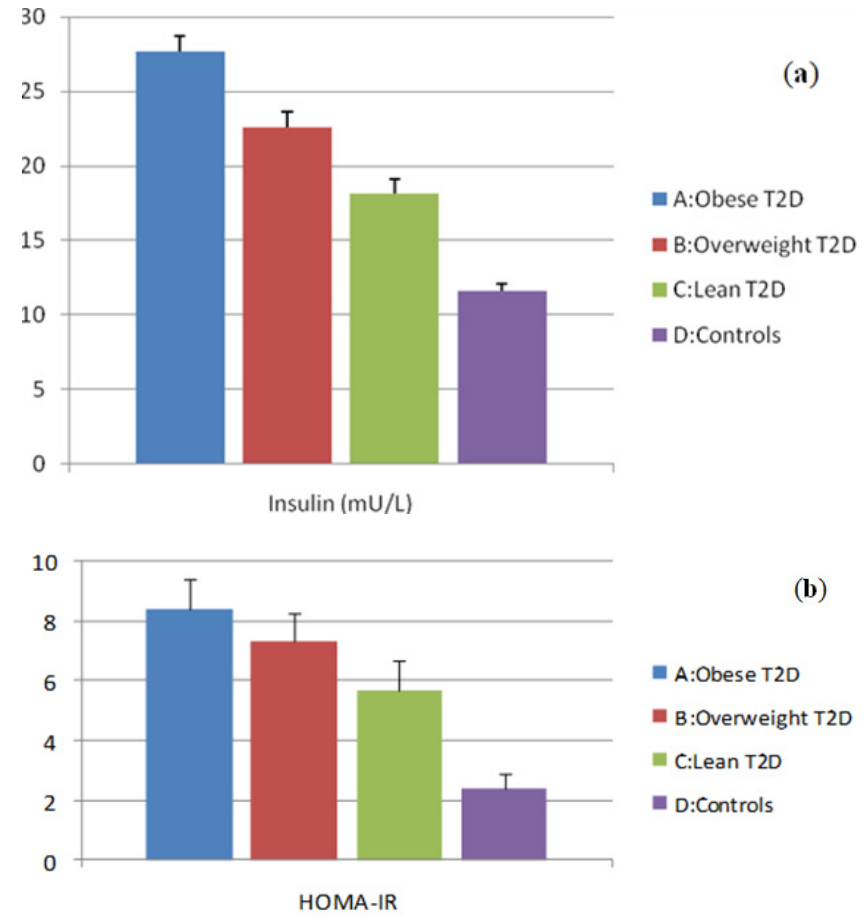
Figure 1. ( a ) Plasma levels of insulin; ( b ) Plasma levels of